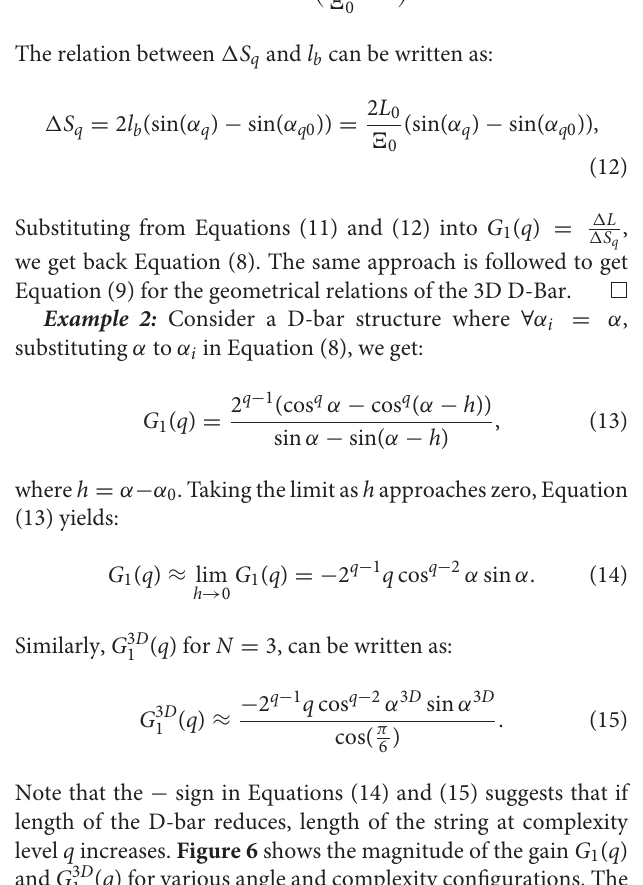
10 ◦ ,15 ◦ , and 20 ◦ . The ordinate shows F =